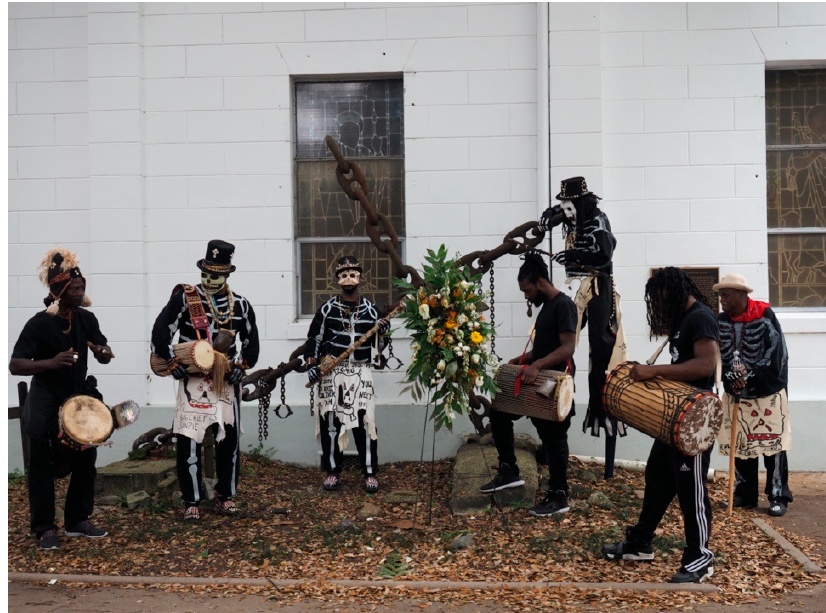
Figure 10. Tomb of the Unknown Slave at St. Augustine Catholic Church in the Tremé neighborhood of New Orleans. Every Mardi Gras, the Northside Skull and Bone Gang, an African-American men’s carnival organization led by Bruce Sunpie Barnes, visits the memorial to pay homage to their ancestors. From left: Seguenon Kone, Bruce Sunpie Barnes, Bruce Brown, Bakari Blackman, Solomon Israel, Zohar Israel, and Ronald W. Lewis. Photograph by Jeffrey David Ehrenreich, courtesy of the Neighborhood Story Project.